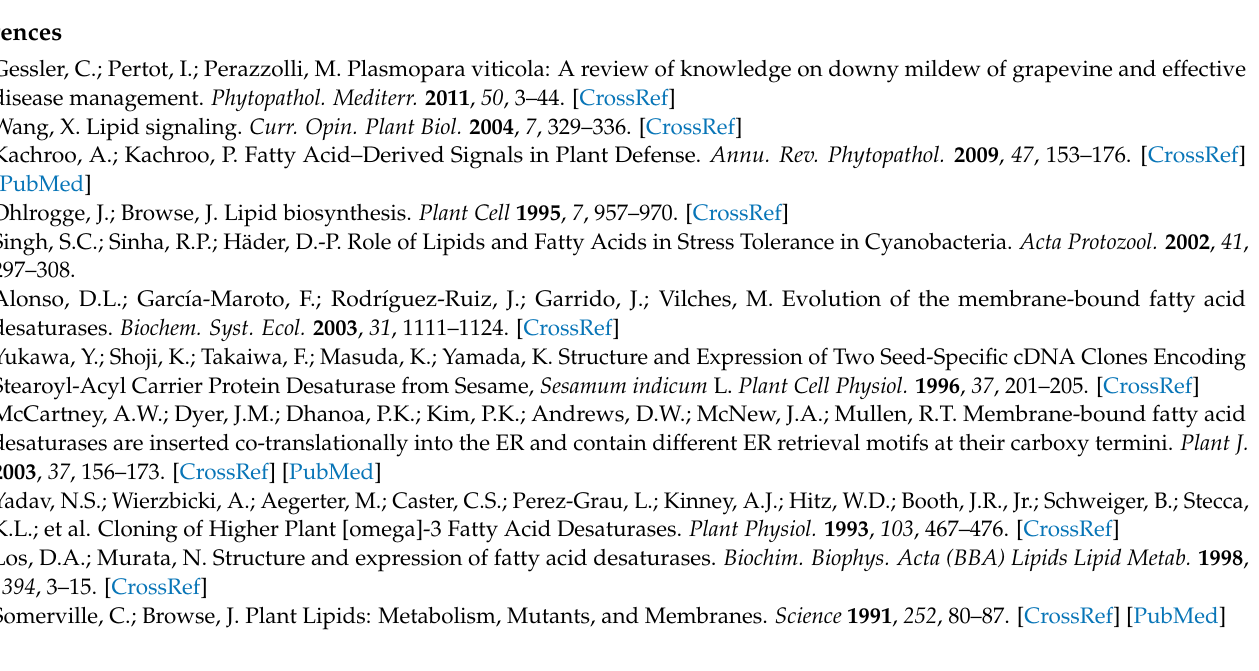
Cis-element analysis of Vitis vinifera fatty acid desaturases gene promoters; Table S3: Protein motifs of Vitis vinifera fatty acid desaturases; Table S4: Protein domains of Vitis vinifera fatty acid desaturases; Table S5: Subcellular prediction of the Vitis vinifera fatty acid desaturases proteins; Table S6: Reference and target genes transcripts primer sequences, amplicon length, amplification efficiency, annealing, and melting temperature are represented; Table S7: Biological process and function of the Vitis vinifera fatty acid desaturases